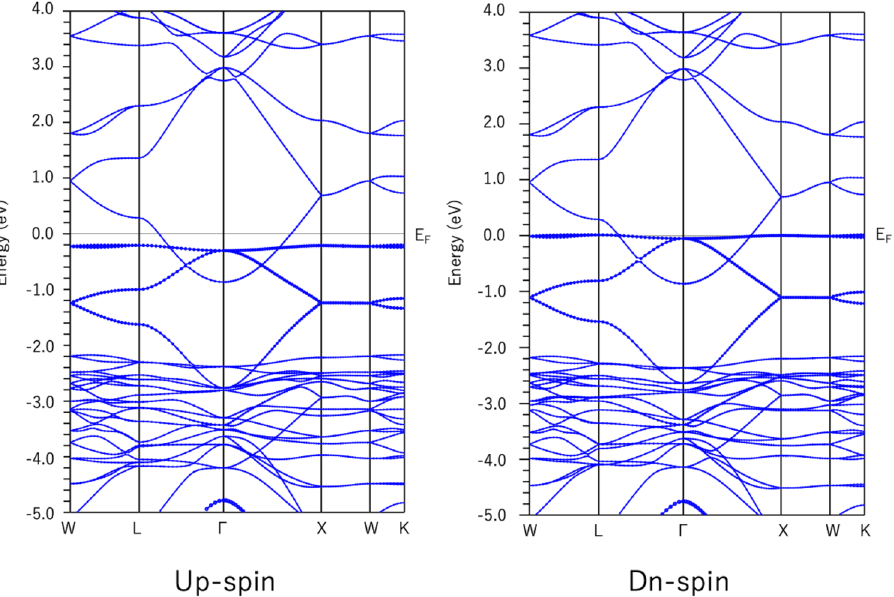
Figure 3. Energy dispersion of ferromagnetic Pb 2 Sb 2 O 7 for up-spin and